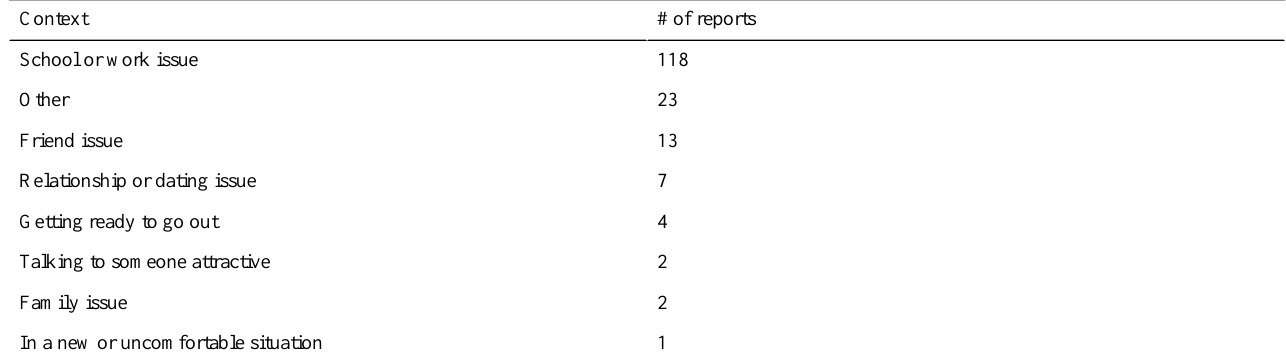
Table 4. Rank ordered contexts for sensorband reports.